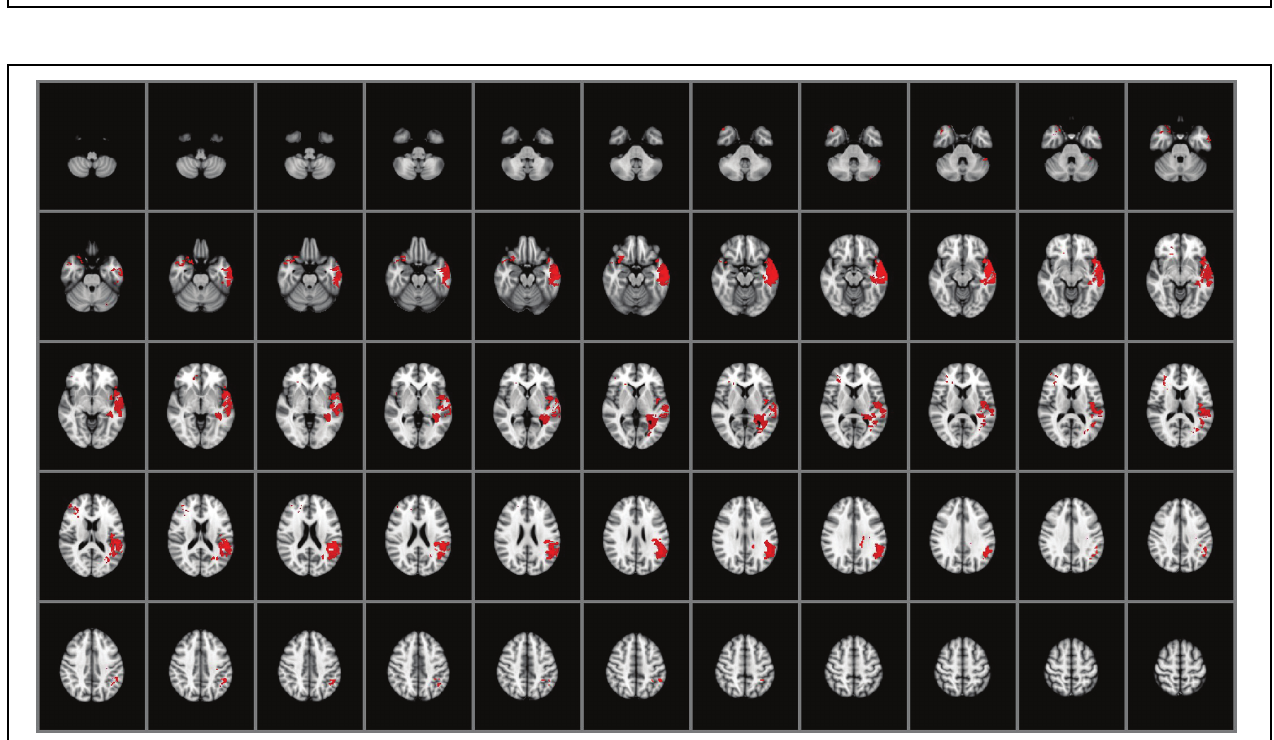
FIGURE 2 | Voxel-based lesion-symptom mapping of managing emotions ( n = 130). The statistical brain map of VLSM results in MNI space is thresholded at q < 0.05 (using a false discovery rate correction for multiple comparisons). In each axial slice, the right hemisphere is on the reader’s left.